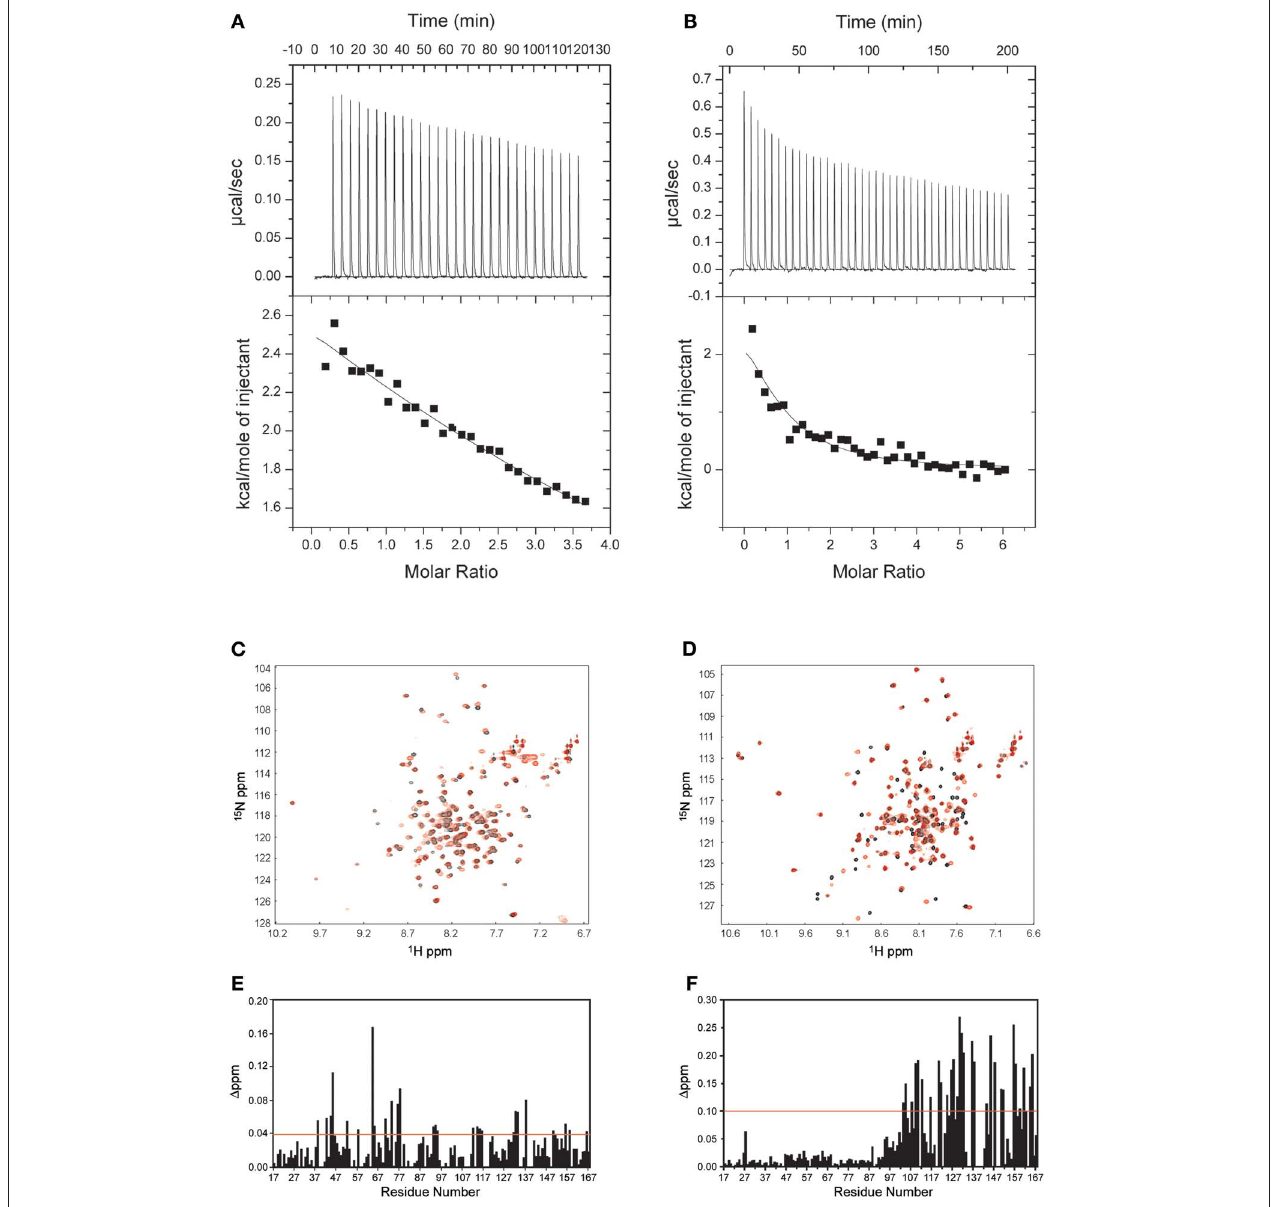
FIGURE A5 | Interactions between CaBP1 and the long NSCaTE motif. (A,C,E) Apo-CaBP1 with NSCaTE peptide: ITC (A) , 1 H– 15 N HSQC (C) and chemical shift perturbation (E). (B,D,F) Ca 2 + /CaBP1 with NSCaTE peptide: ITC (B) , 1 H– 15 N HSQC (D) and chemical shift